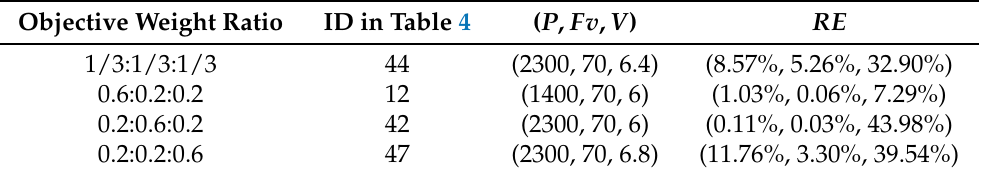
Table 7. Optimal process parameters and relative errors ( RE ) of the proposed approach under different weight